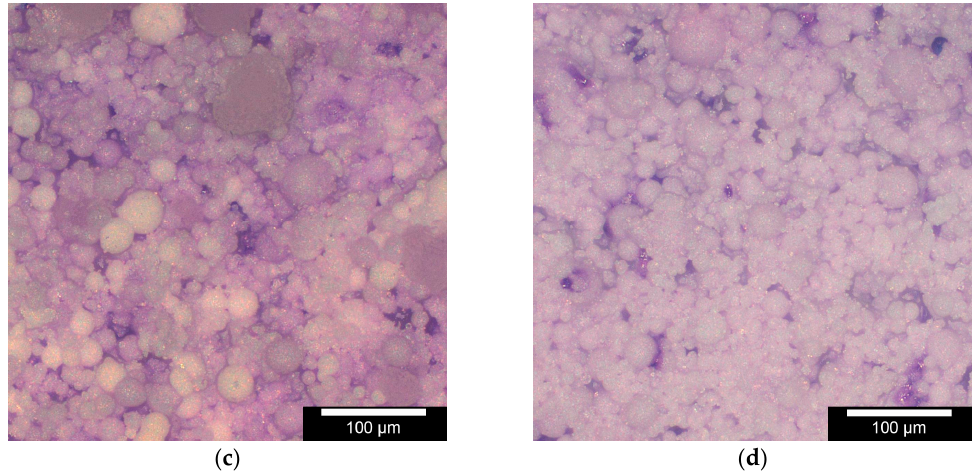
Figure A2. Giemsa Staining of MG63 cells on the Scaffolds after 24 h: ( a ) BG; ( b ) TCP; ( c ) 50/50; and ( d ) 70/30: Images taken with Olympus BX 51 with reflected light in 10× magnification. The staining was according to the protocol given in Romeis [43].